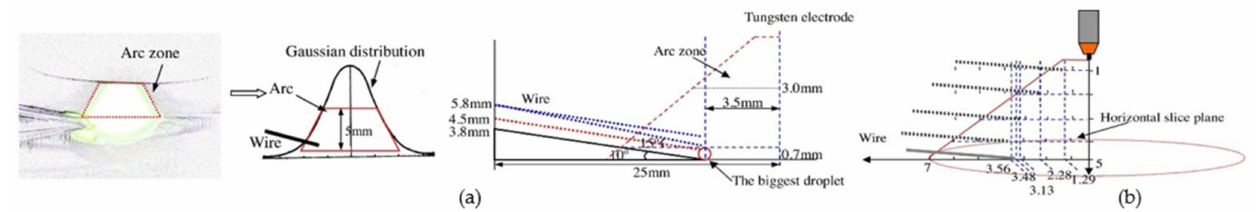
Figure 43. Mechanism for wire feed variation for bridge transfer: ( a ) arc modelling; ( b ) wire feed optimisation and displacement compensation. Reprinted with permission from Ref. [83]. Copyright 2017